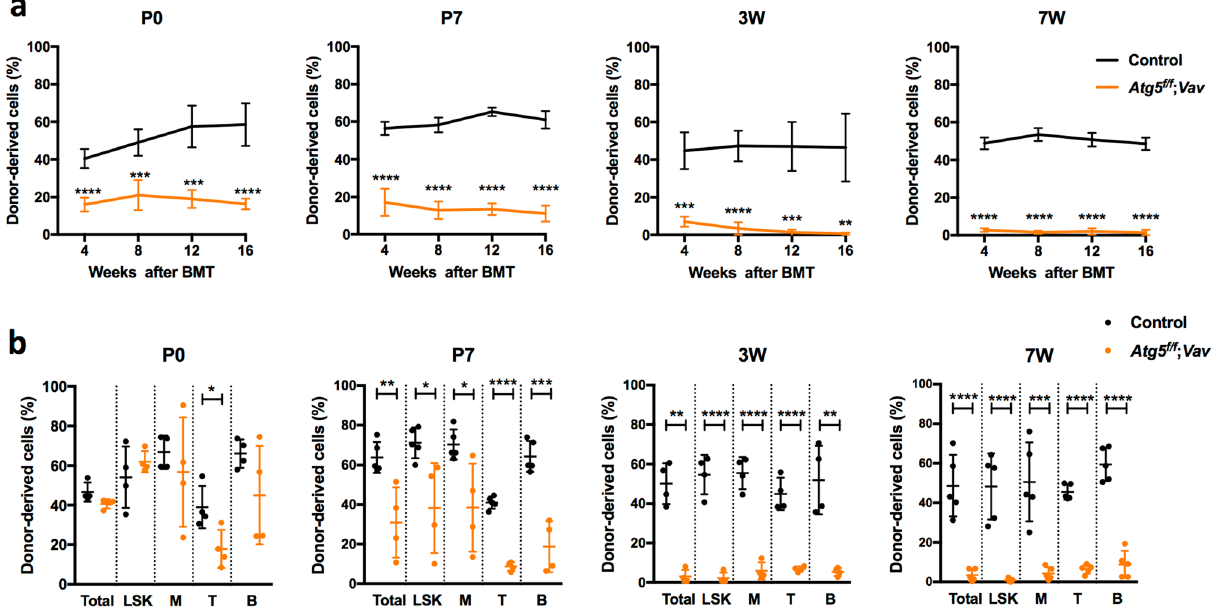
Figure 2. Competitive reconstitution analysis of BM cells from control ( Atg5 f / w ; Vav) and Atg5 f / f ; Vav mice at P0, P7, 3 weeks, and 7 weeks. ( a ) Frequency of donor-derived cells among total PB cells were analysed every 4–16 weeks after transplantation. Data are the mean ± SD (n = 4–5). ( b ) Frequency of donor-derived cells among total, LSK, myeloid (M), T (T), and B (B) cells in BM were analysed at 16 weeks after transplantation. Data are the mean ± SD (n = 4–5). Horizontal line indicates the mean of values.